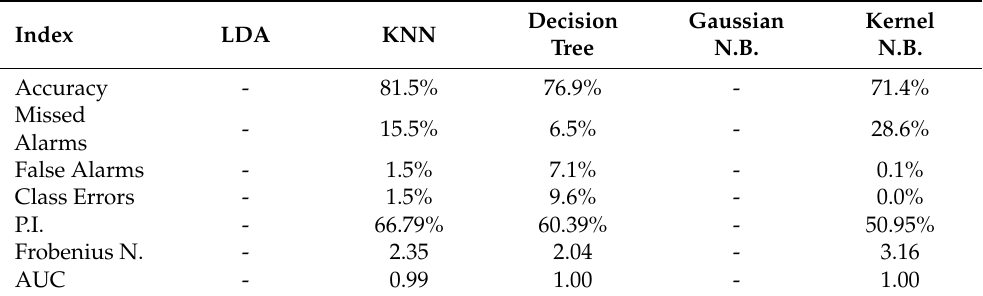
Table 1. Performance indices obtained with the original dataset with n features. It is worth noting that LDA and GNB were not applicable due to the high dimensionality of the dataset.